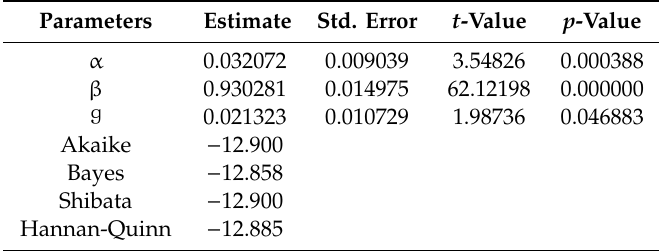
Table A2. Parameter Estimates of New Zealand’s Islamic-conventional ADCC-GARCH model. Table A9. Parameter Estimates of Peru’s Islamic-conventional ADCC-GARCH model. Table A3. Parameter Estimates of China’s Islamic-conventional ADCC-GARCH model. Parameters Parameters